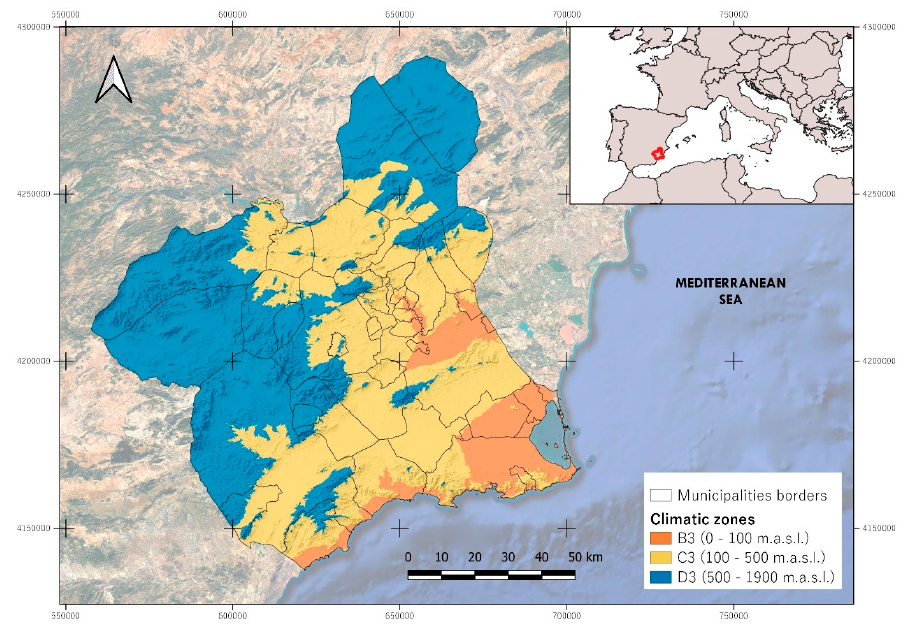
Figure 3 . Digital elevation model and location of Region of